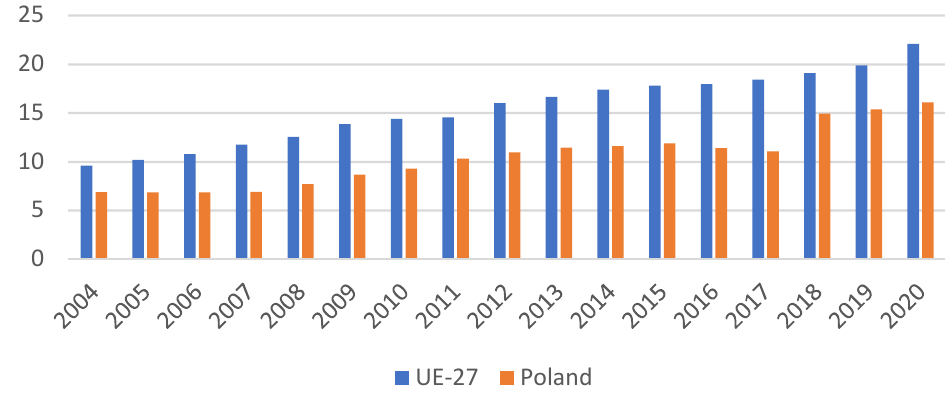
Figure 1. Overall share of energy from renewable sources in Poland and UE-27 [%]. Source: [7].